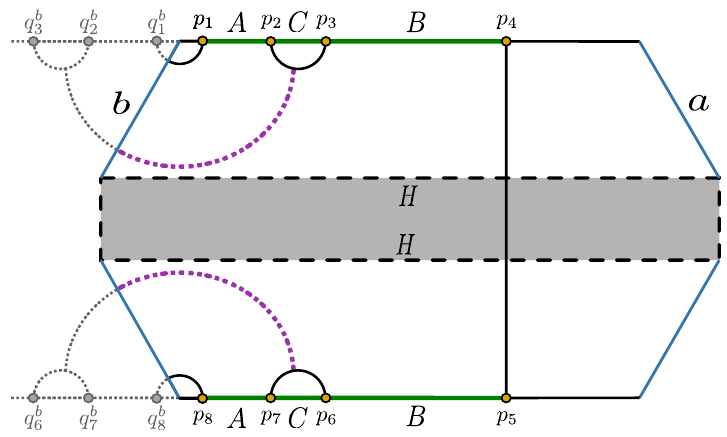
Figure 27 . The endpoints of the intervals A and B and the image points in the two BCFT 2 copies are identified similarly as in figures 20 and 21 with p 4 = p 5 = r 4 .